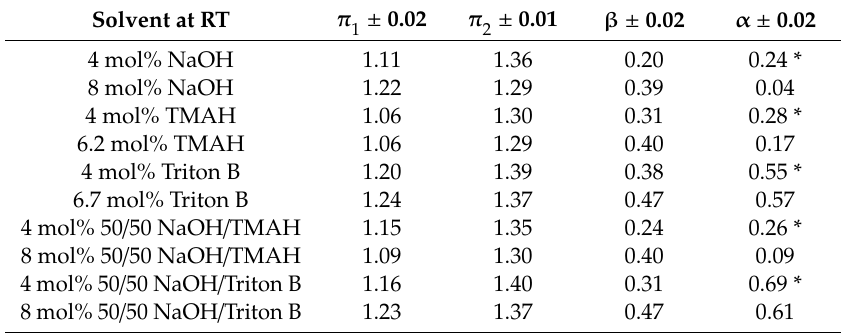
Table 5. The Kamlet-Taft parameters for increasing concentrations of base, obtained at room temperature (* values are an average of measurements at 15 and 35 ◦ C). ± Solvent at RT π 1